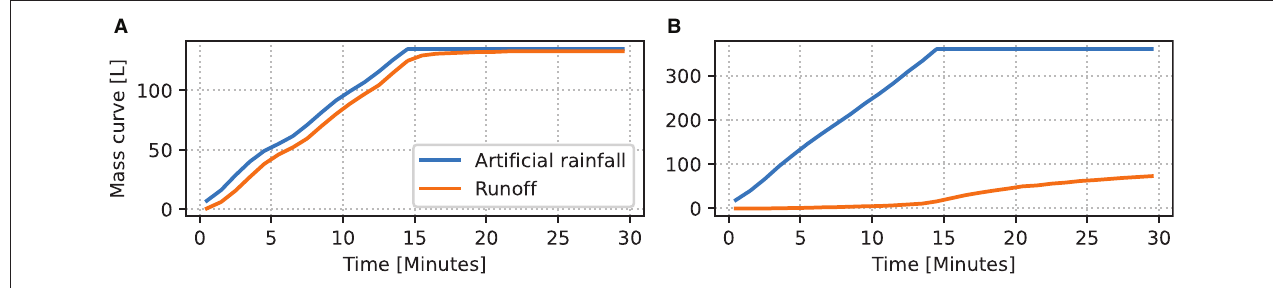
FIGURE 2 | Mass curves of artificial rainfall and runoff for experiments (A) “empty test track” (no substrate) and (B) 2019–47 (substrate), respectively.